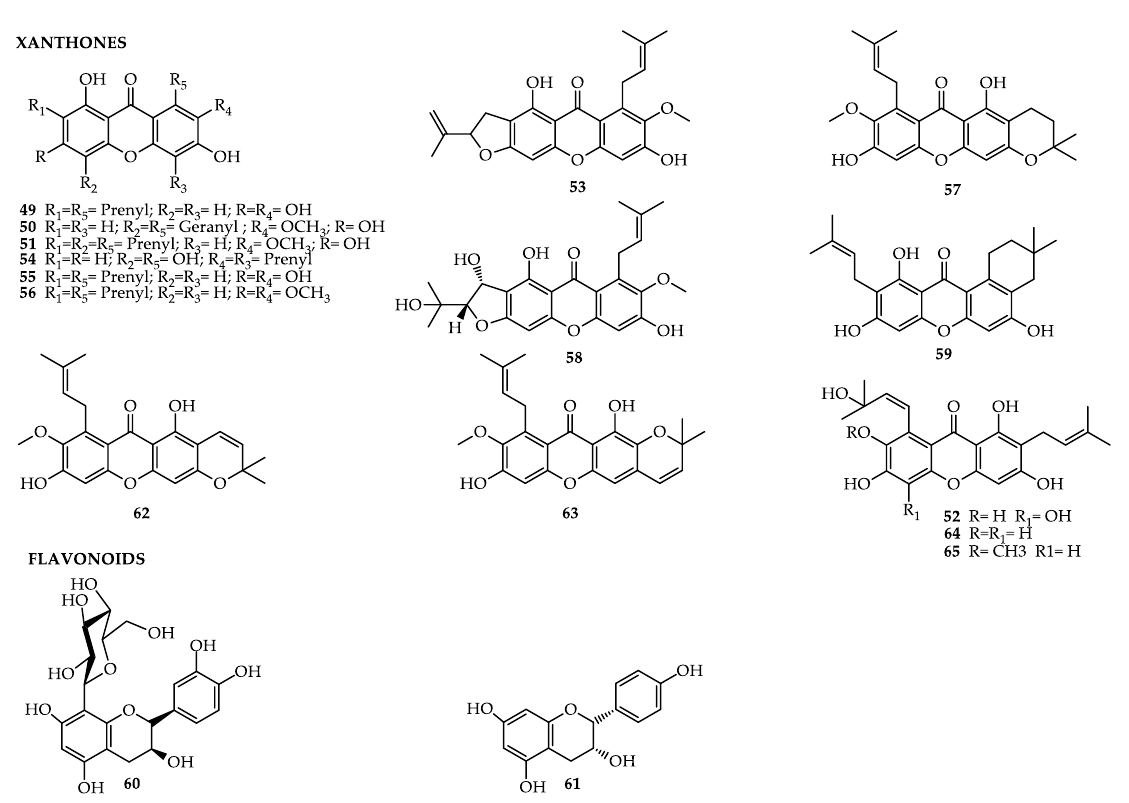
Figure 5. Bioactive compounds of Garcinia mangostana.